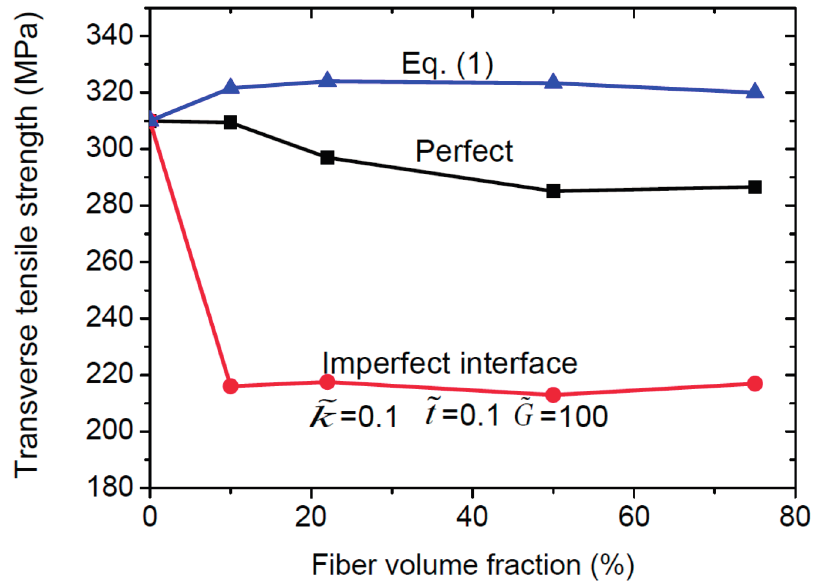
Figure 8. Ultimate transverse tensile strength with respect to the fiber volume